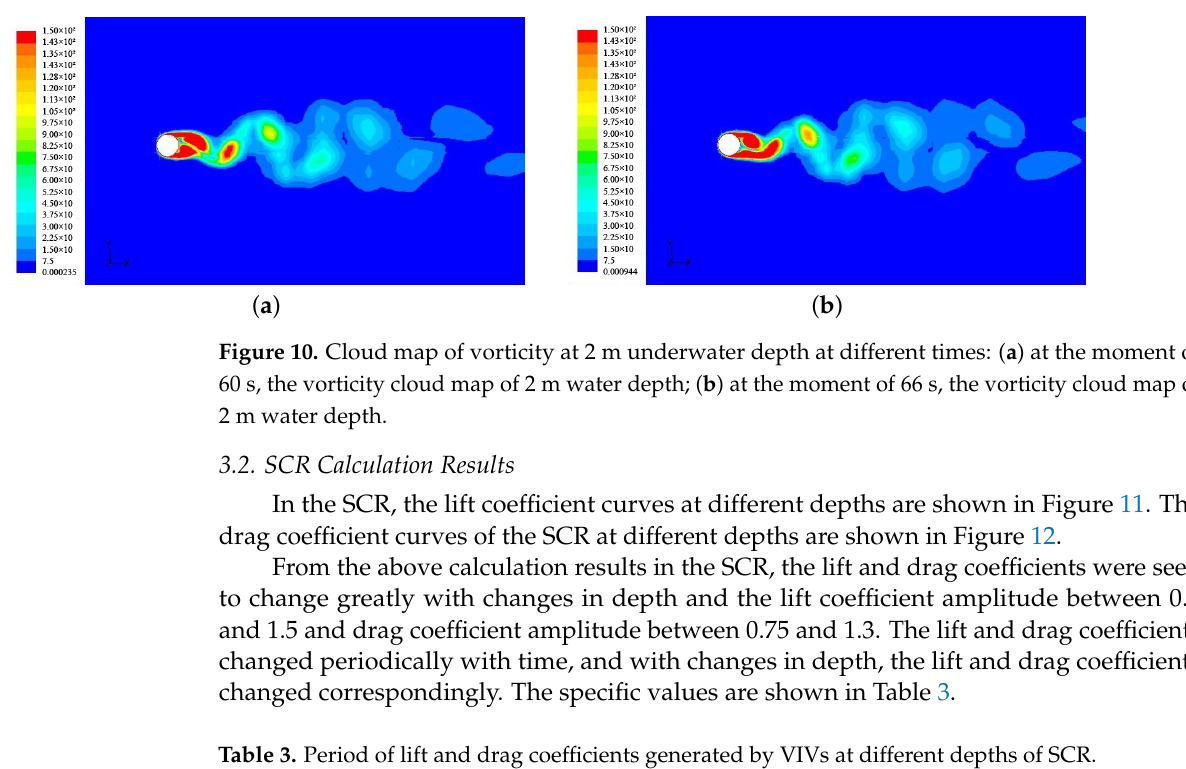
Figure 9. Cloud map of vorticity contour behind the TTR at different underwater depths: ( a ) cloud map of vorticity contour behind the TTR at 1 m underwater; ( b ) cloud map of vorticity contour behind the TTR at 2 m underwater; ( c ) cloud map of vorticity contour behind the TTR at 3 m underwater; ( d ) contour map of vorticity behind the TTR at different depths.